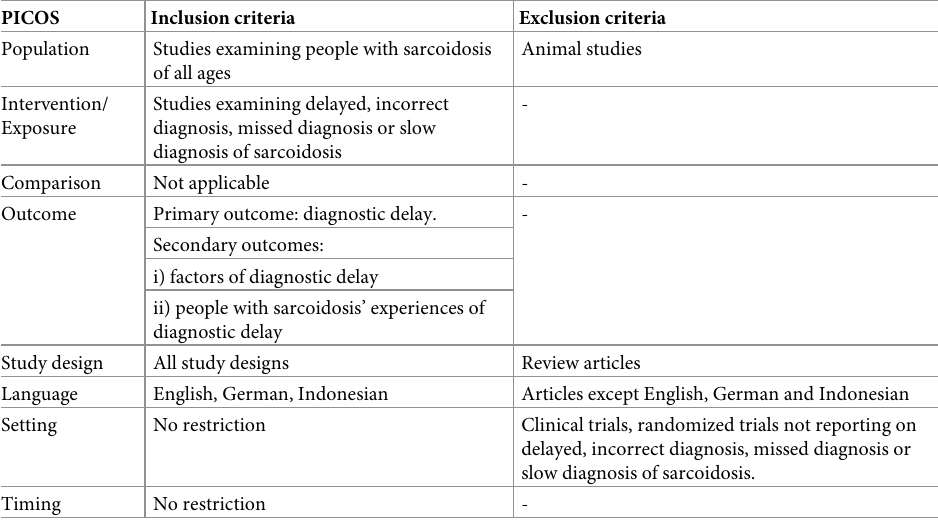
Table 2. Inclusion and exclusion